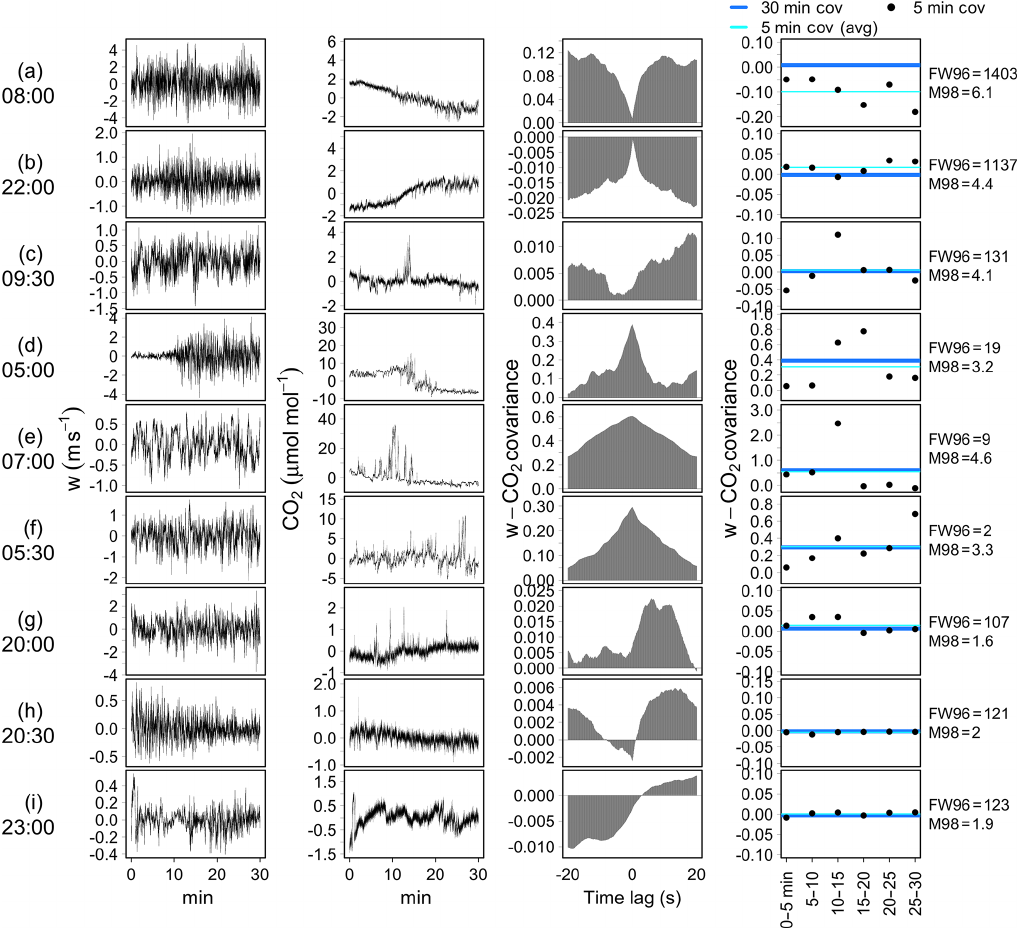
Figure 10. Application of stationary tests to a selection of EC raw data collected at the FI-Hyy site. From left to right: vertical wind speed ( w , ms − 1 ); CO 2 time series (µmolmol − 1 , after mean removal); cross-covariance function (CCF); comparison of 5min covariances (black points), their average (cyan lines) and 30min covariance (blue lines). FW96 and M98 test statistics are reported on the right-hand